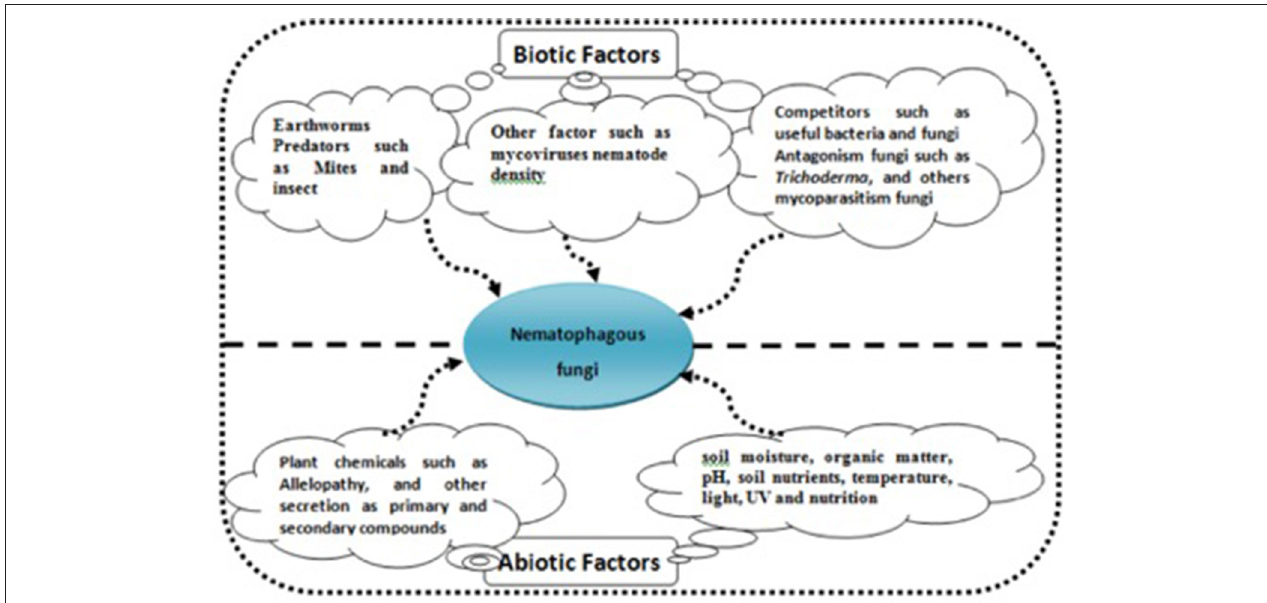
FIGURE 4 | Thi figure showed biotic and abiotic factors that affect the biocontrol agent nematophagous fungi.